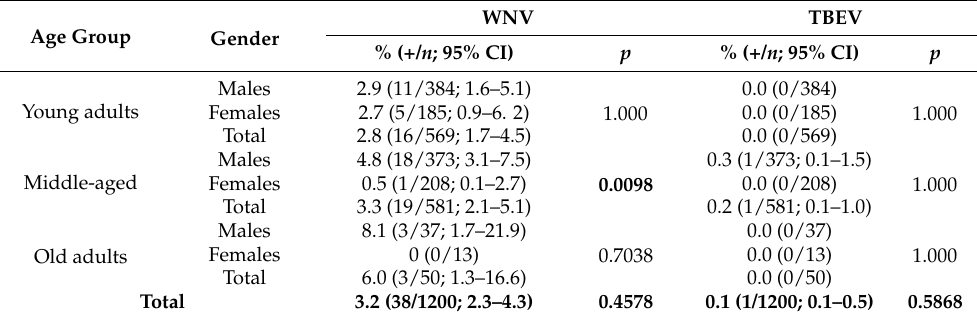
Table 4. WNV and TBEV seroprevalence by SNT according to age group and gender. Age Group